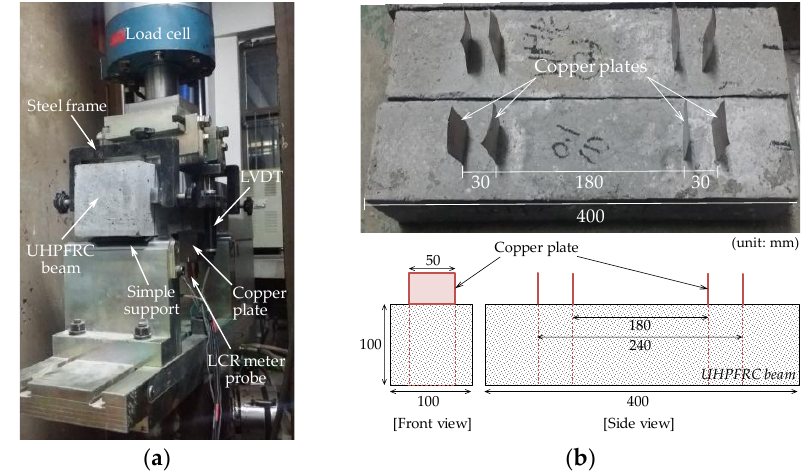
Figure 3. Test setup for four-point bending test: ( a ) test picture; and ( b ) geometrical details of beam.